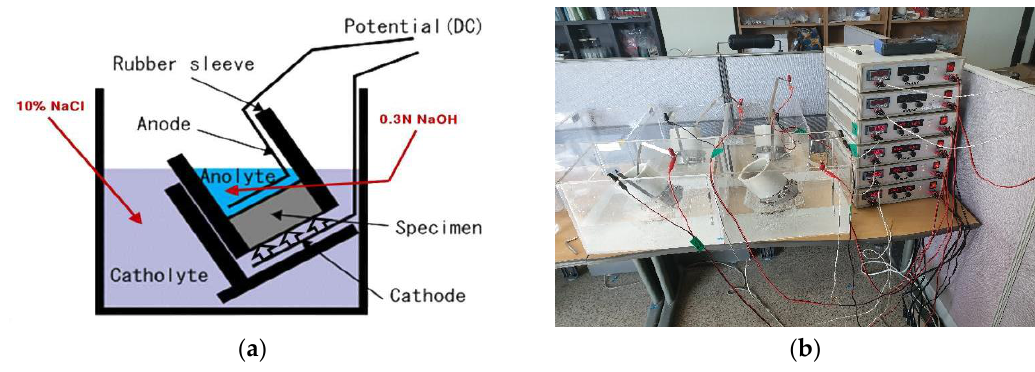
Figure 3. ( a ) One arrangement of the migration set-up; ( b ) Photograph image of NT BUILD 492 Test setup.